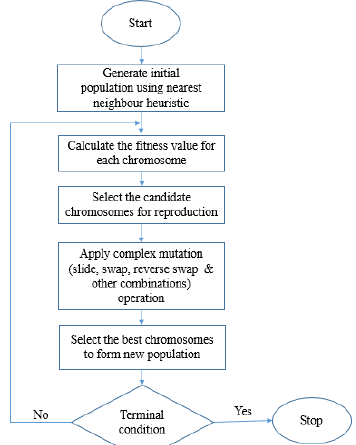
Fig. 7. Flowchart of the proposed